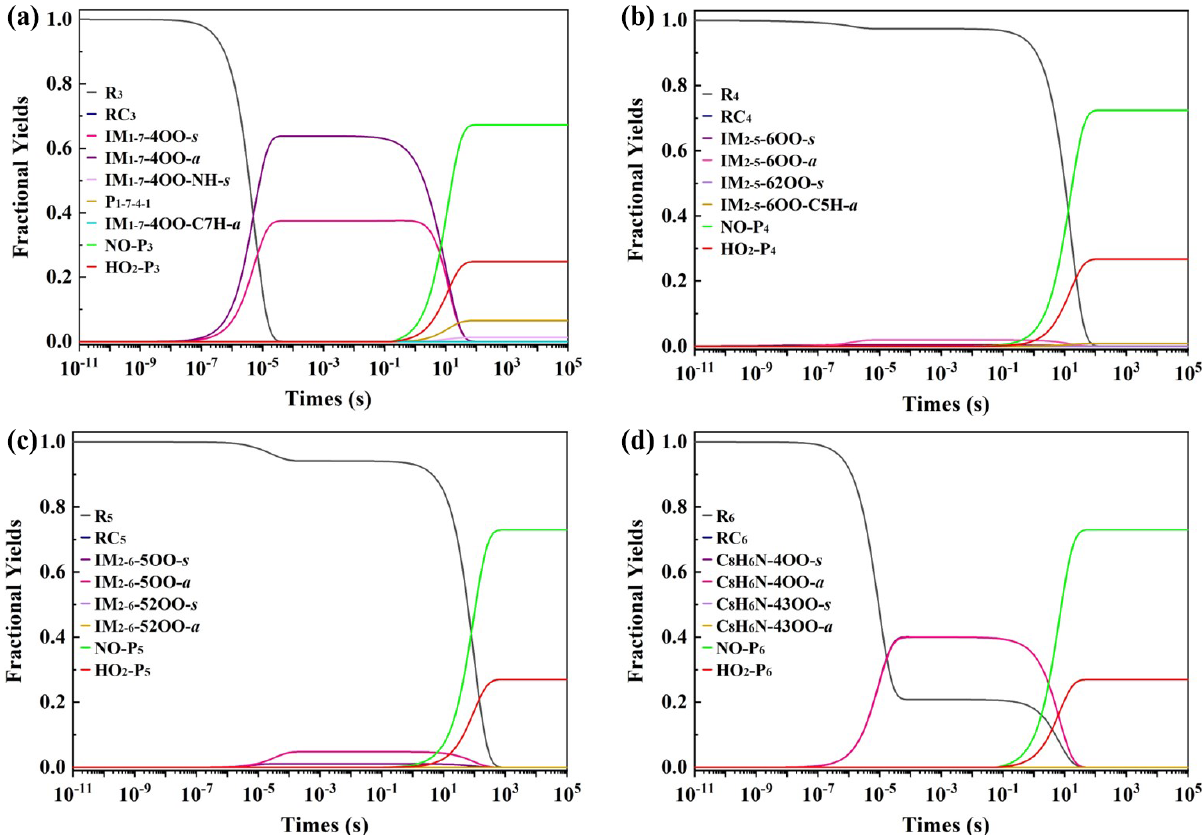
(cid:113) conditions) as a function of time in the reactions of